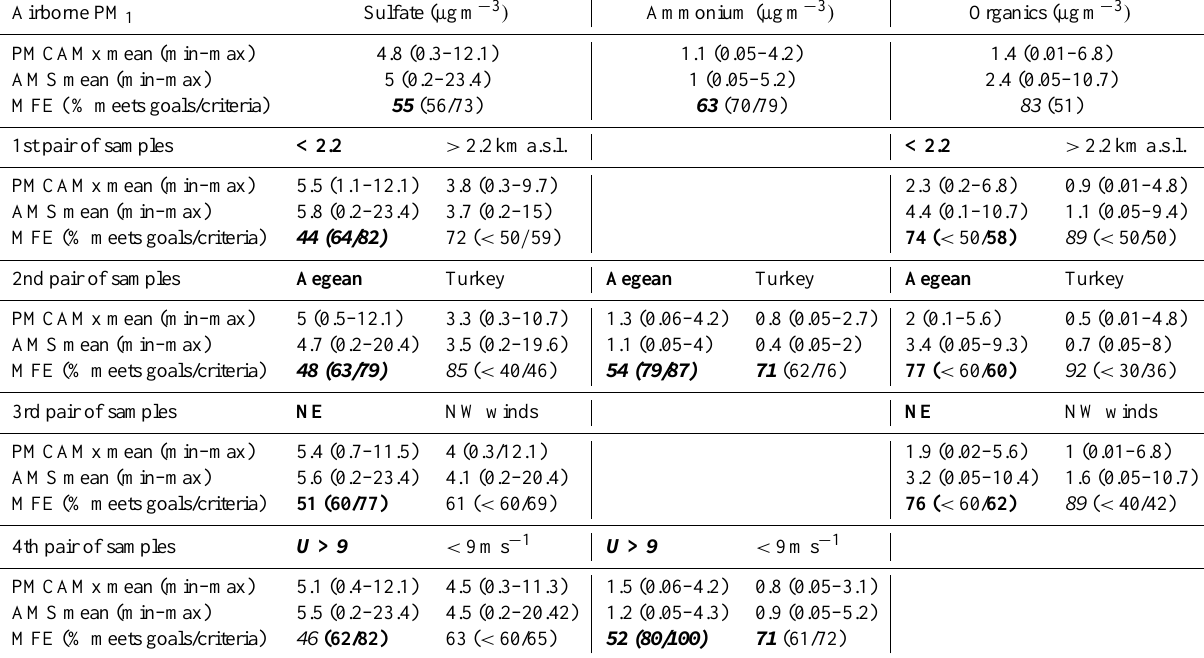
Table 4. Mean and mean fractional error (MFE) values for the complete sample and for paired sub-samples of the airborne model- measurement data set. Paired sampling is based on the methodology described in Sect. 3.4. MFE with bold italic (italic) fonts indicate good (poor) model performance, according to the selected evaluation criteria (cf. Table S2). The rest of the model outputs (MFE with black fonts) are acceptable (average model